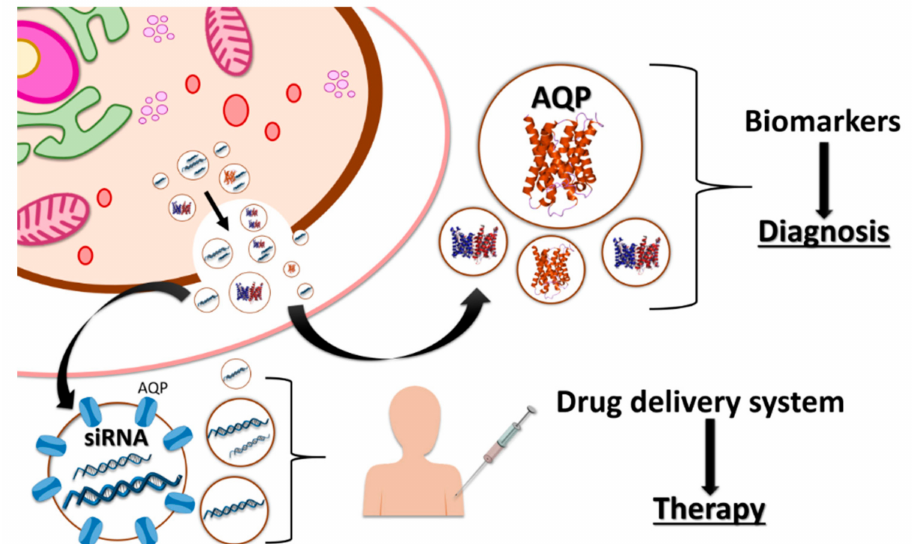
Figure 2. Exosomes containing aquaporins (AQPs) have been used to develop novel biomedical tools. As the abundance of AQPs in exosomes is modified under a specific disorder, they can be used as new biomarkers in the diagnosis of different diseases. Exosomes could also be used as drug delivery systems as they are able to cross biological barriers and guarantee the stability and bioavailability of drugs. One of the biological functions of exosomes is the delivery of RNA, based on which exosomes are used to transport siRNA used in